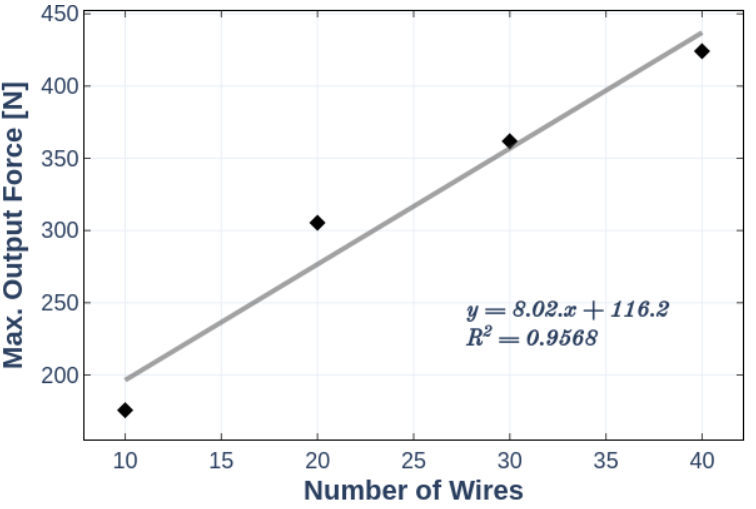
Figure 11. Number of wires vs. maximum force of